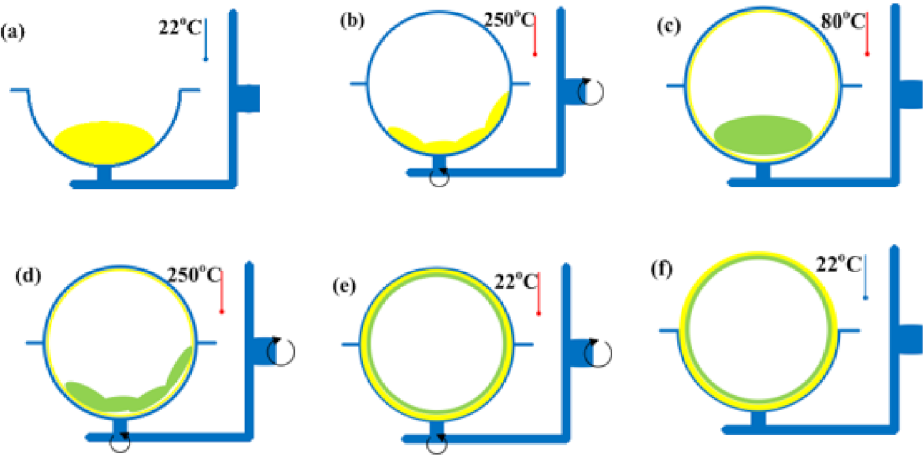
Figure 2. Stages in rotational moulding of double-layer products: ( a ) first loading, ( b ) first heating, ( c ) second loading, e.g., of a blowing agent, ( d ) second heating, ( e ) cooling, ( f )